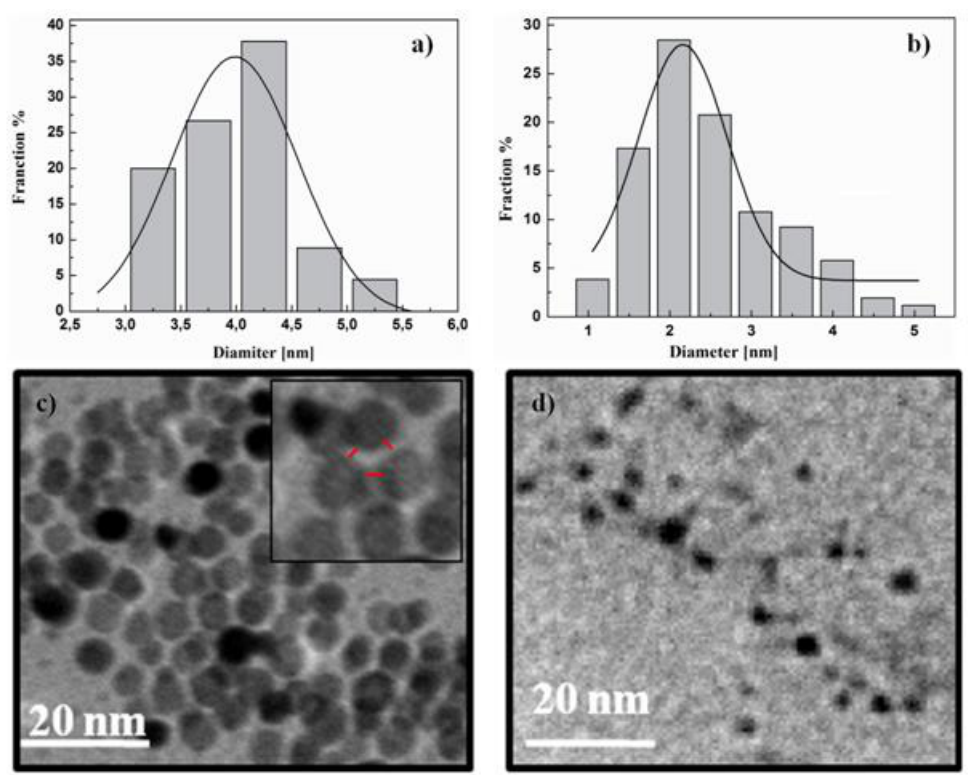
Figure 3. (a) and (b) Size distribution histogram of the nanocomposite obtained by thermal decomposition of silver n-dodecyl-mercaptide and of silver cyclohexyl-mercaptide, respectively. (c) and (d) The Transmission Electron Microscopy (TEM) micrograph of nanocomposites. The inset shows a detail of nanoparticles aggregate and marked by red lines the interparticles distance, D pp